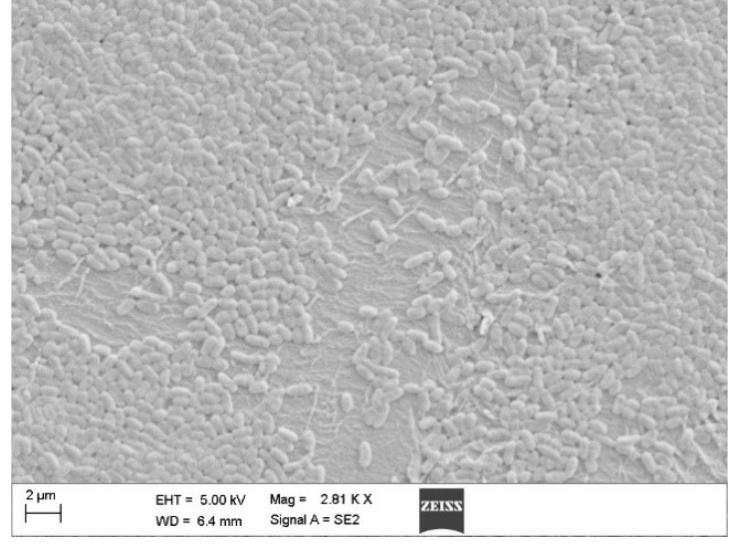
Figure 1. Single cell morphology of strain SC16 observed by SEM.